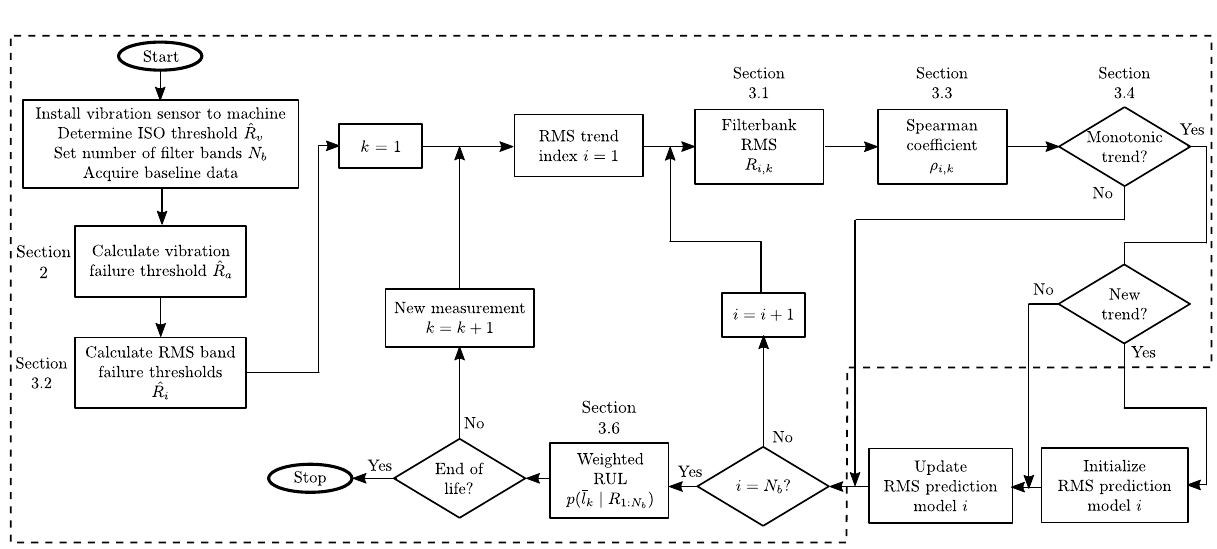
Figure 3: Flowchart of the proposed method. The stapled line indicates the proposed method for identifying monotonic RMS trends and calculating the weighted